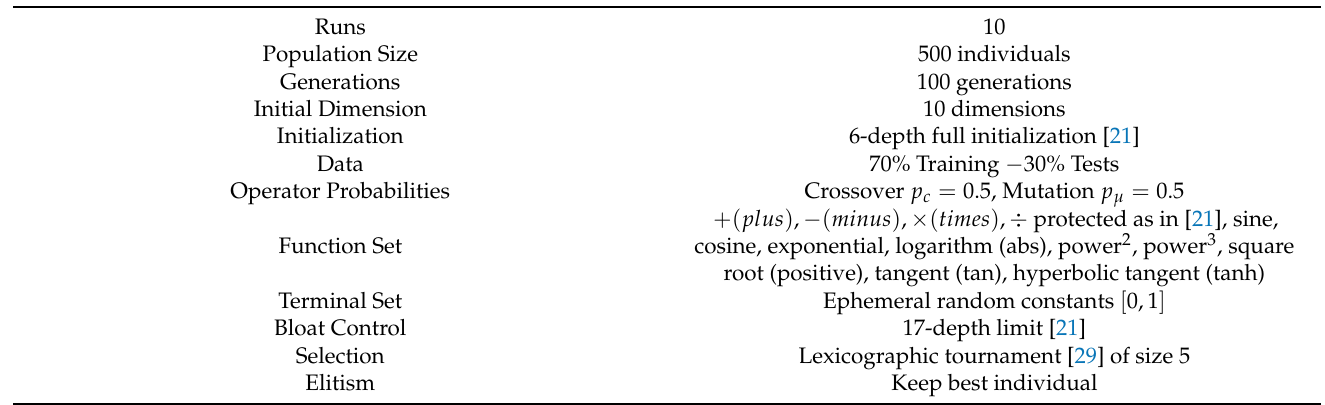
Table 4. M3GP setup settings.